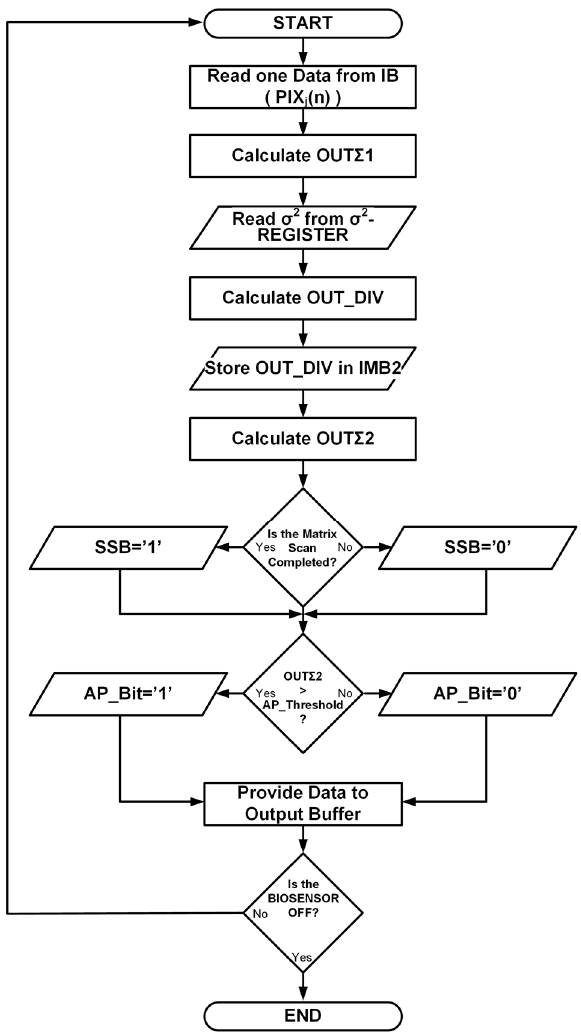
Figure 7. Flowchart of implemented PCA algorithm.